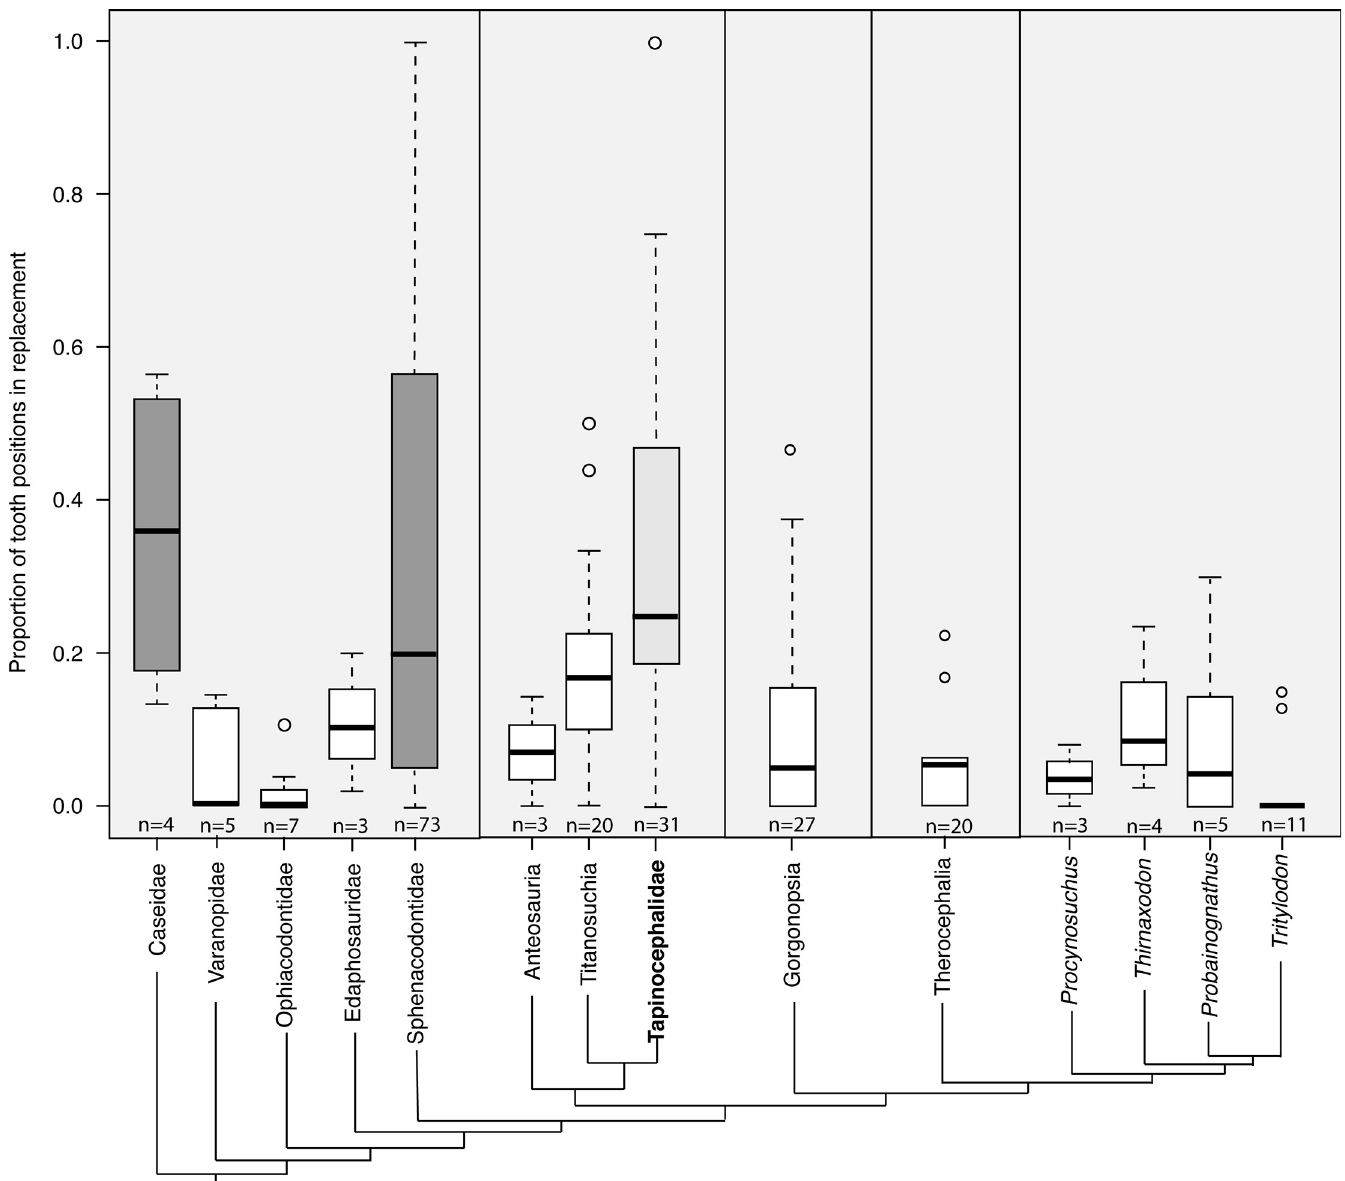
Fig 7. Proportion of tooth positions in replacement in fossil synapsids. Proportions are such that 0.0 represents no positions visibly in replacement and 1.0 represents all positions in visible replacement. With the exception of pelycosaurs and dinocephalians, synapsid clades generally have an average proportion below 0.1. Within pelycosaurs, caseids and sphenacodontids (dark grey boxes) have a significantly higher average proportion of teeth in replacement than do other pelycosaurs, and tapinocephalids (light grey box) have a higher average proportion than other dinocephalian clades. Caseids ( p = 0.868) and sphenacodontids ( p = 0.600) are the only groups to not have significantly fewer average number of teeth in replacement than